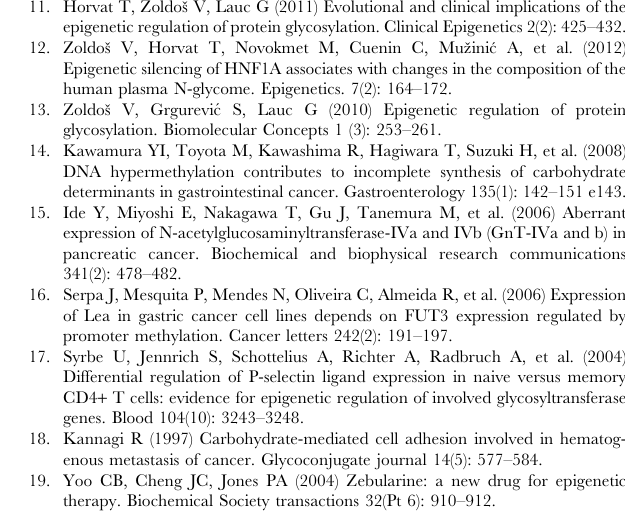
Figure S1 HPLC analysis of the HeLa cell membrane N - glycome. Only the most abundant glycans in each HPLC glycan peak (GP) deduced by exoglycosidase digestions are shown. Black square presents N-acetylglucosamine, grey circle mannose, white circle galactose, triangle fucose and diamond presents sialic acid. Figure S2 Changes in HeLa cell membrane N -glycome induced by Trichostatin A (A), Na- butyrate (B) and zebularine (C), and N-glycome profile after recovery in a drug-free environment. The error bars represent standard